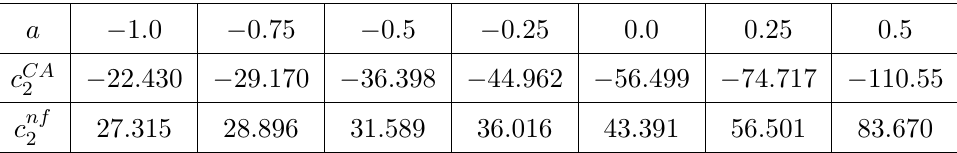
Table 2 . Coe(cid:14)cients of the two-loop soft function constant as de(cid:12)ned in eq. (2.38). and c 2 ( a ) is given by [46, ~ S